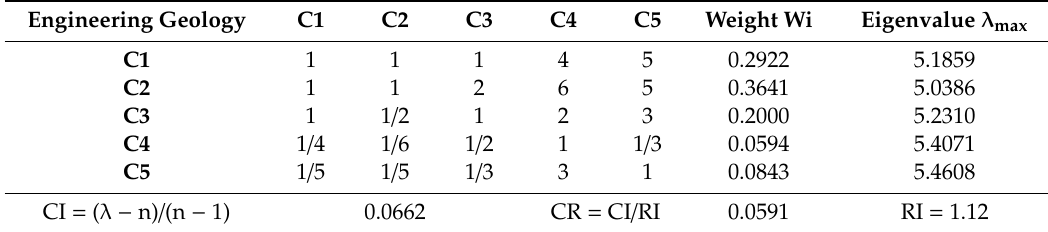
Table 7. A single sequence of the engineering geology and consistency test.